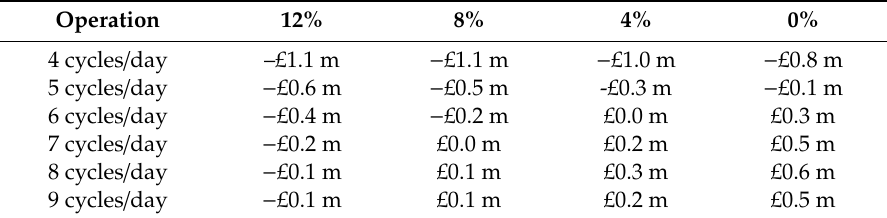
Table 11. NPV LI battery-gas engine hybrid (£